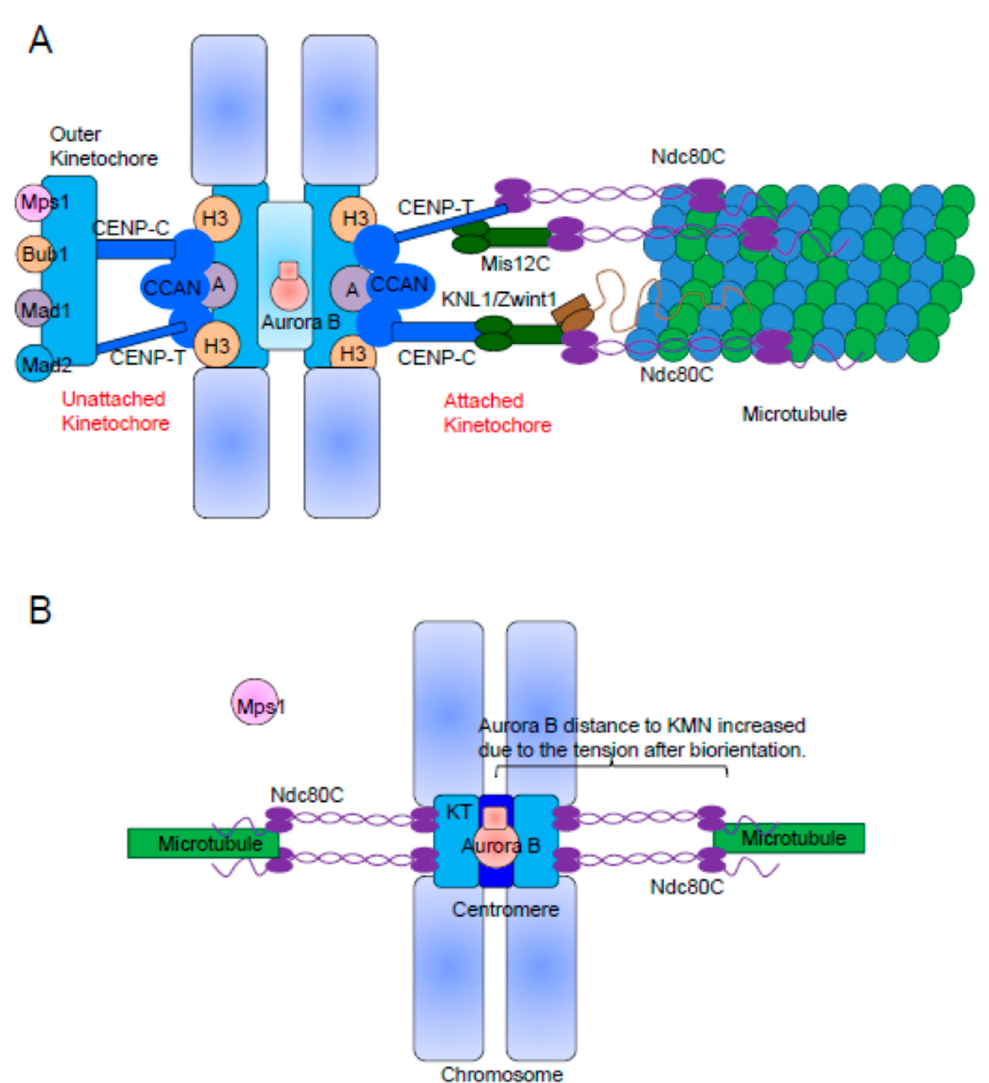
Figure 2. The molecular models to couple microtubule attachment with SAC signaling: ( A ) A model of the competitive binding to Ndc80C between microtubule and Mps1 kinase. Due to the competitive binding with Ndc80C, the microtubule attachment leads to the dissociation of Mps1 from the kinetochore. As a consequence, PP1 and PP2A dephosphorylate Mps1 substrates Knl1, Bub1 and Mad1. SAC signaling is quenched quickly. ( B ) A model of the spatial separation of Aurora B with the outer kinetochore substrates upon tension establishment. Upon the establishment of bipolar spindle attachment, Aurora B is unable to phosphorylate its outer kinetochore substrates (most importantly, Hec1) due to tension-caused spatial separation. Without the persistent phosphorylation by Aurora B, dephosphorylated Hec1 results in the dissociation of Mps1 and, finally, the silence of SAC